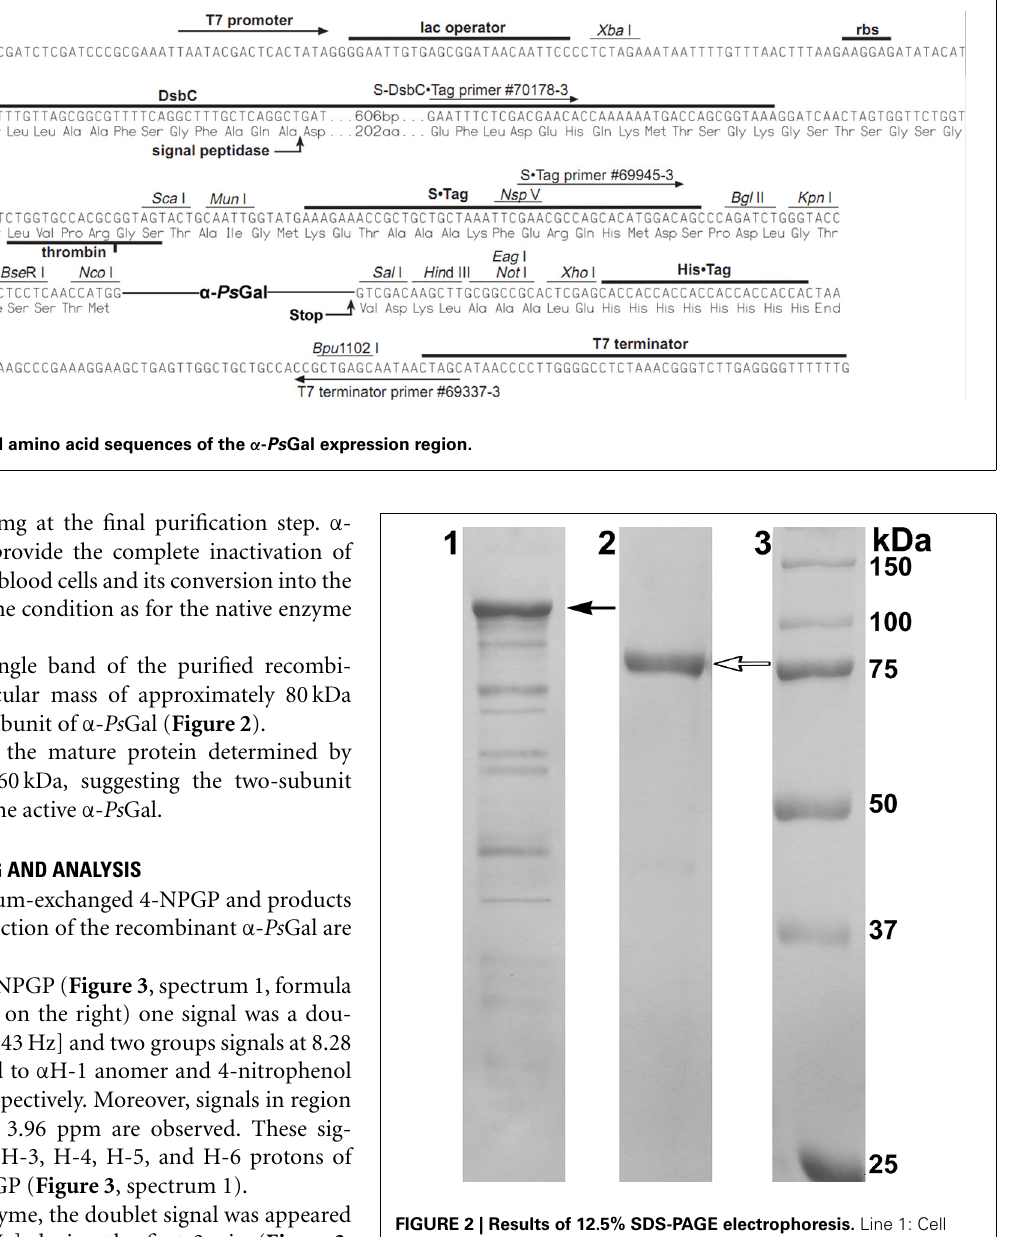
responded to β -D-galactofuranose (Angyal and Pickles, 1972) ( Figure 3 , spectra 4 and 5, equation of equilibrium of D-galactose is shown on the right Zhu et al., 2001). Signals in the anomeric region, which could indicate the emergence of new products of the reaction or formation of O-glycosidic bond in the spectra were not